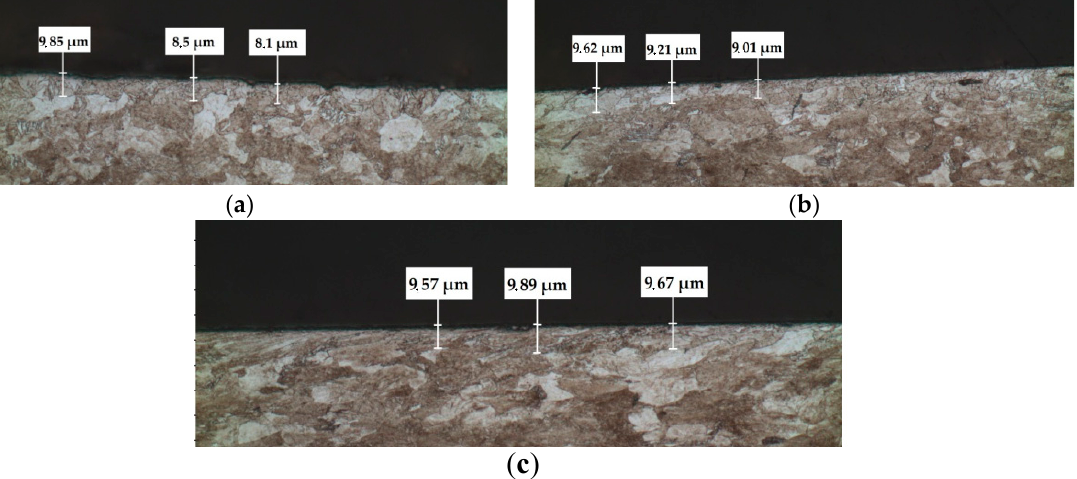
Figure 6. Thickness of the fine grain layers after each pass of the multipass drawing process through α = 5° dies: ( a ) the first pass, ( b ) the second pass, (c) the third pass.